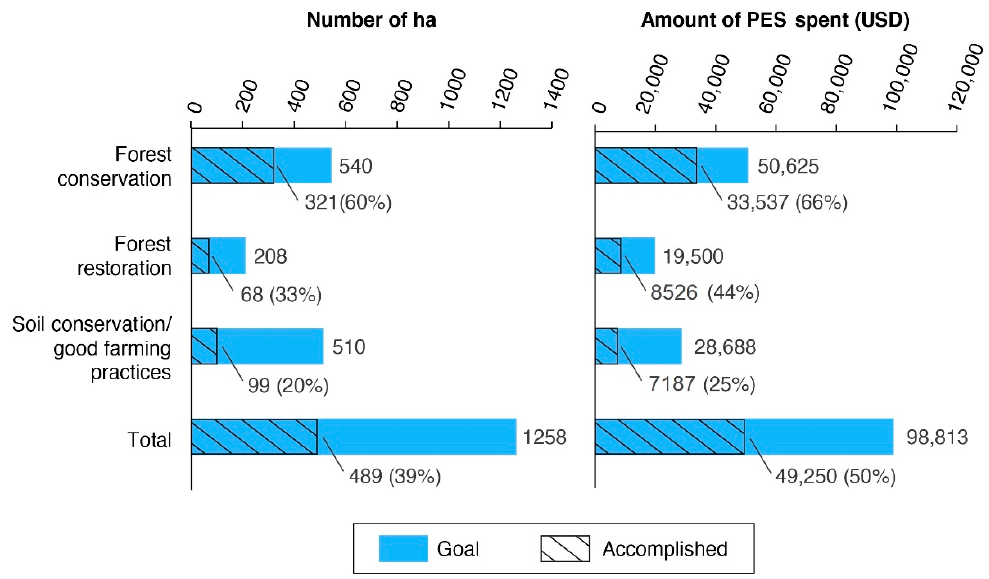
Table 2. Number of properties (N) and areas of implementation for the FLR practices involved in the Water Producer Project in the Joanópolis and Nazaré Paulista municipalities, Piracicaba, Capivari, and Jundiai Watershed, Atlantic Forest, Brazil.